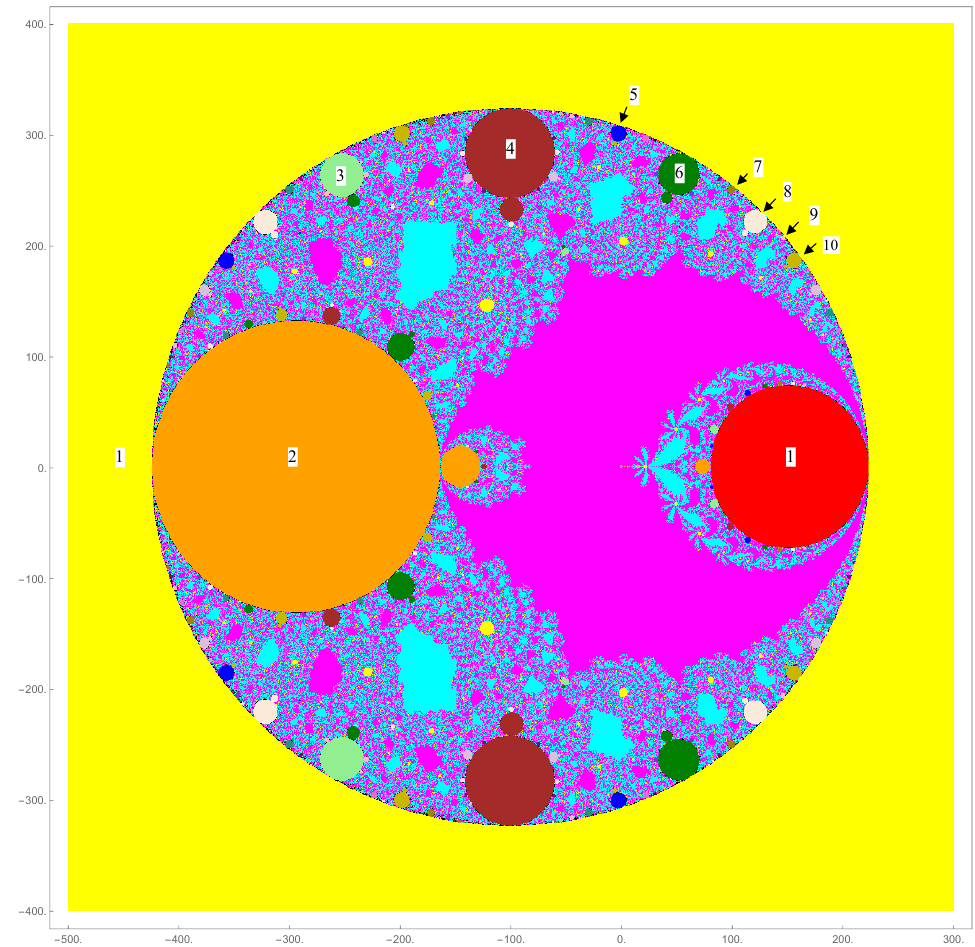
Figure 1. Parameter space P associated with critical point ζ 1 ( λ )